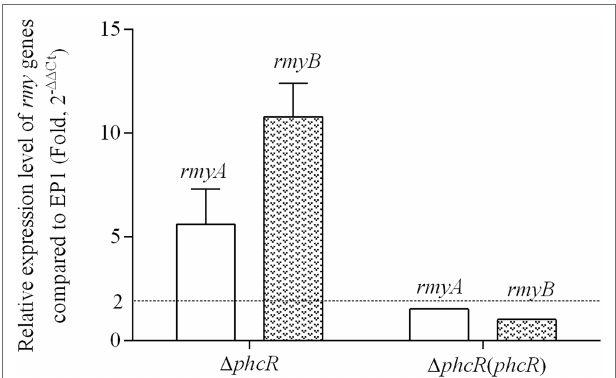
FIGURE 3 | qRT-PCR analysis of rmyA and rmyB in wide type strain EP1, phcR deletion mutant ( Δ phcR ) and complementary strain Δ phcR ( phcR; OD 600 = 1.0). The results were calculated as 2 – ΔΔ Ct , – ΔΔ Ct = − ( Δ Ct mutant – Δ Ct wt ). Three biological repeats (independent cultures) and three technical repeats were done to calculate and compare the values, mean values of all experiments were averaged with SD (error bars) by using the GraphPad Prism 6.0 software.